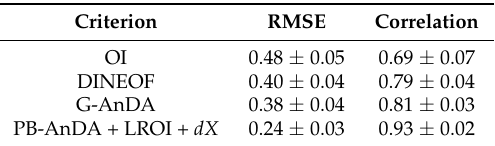
Table 2. Interpolation performance for the MW SST case-study: mean root mean square error (RMSE) and correlation coefficients with the MW SST for OI, DINEOF, G-AnDA and PB-AnDA methods. We refer the reader to the main text for the details on the considered parameterizations.